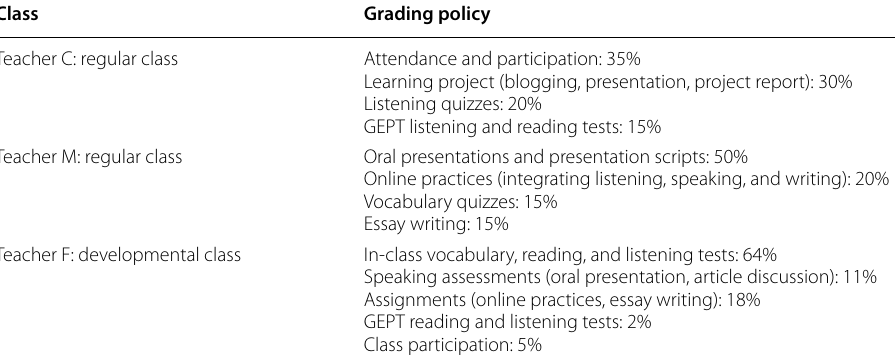
Table 3 Grading policies of each class Class Grading